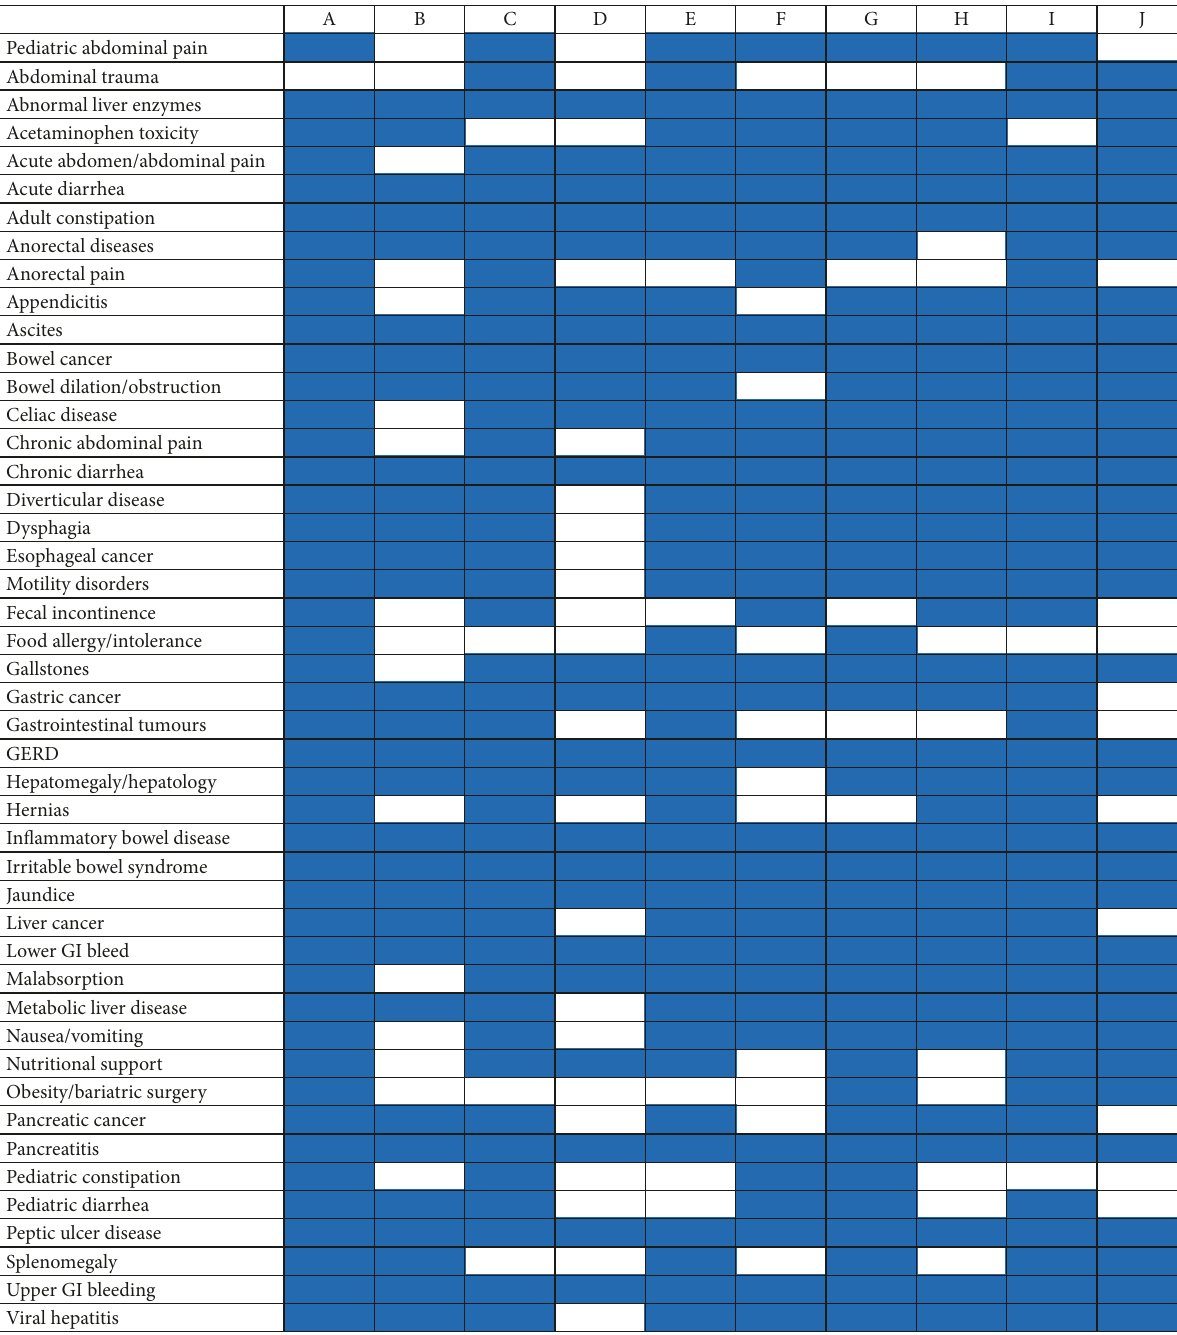
Figure 3: Gastroenterology curriculum